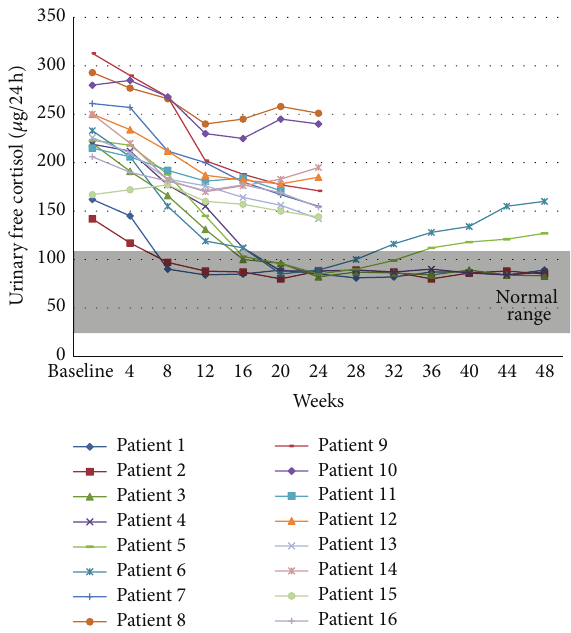
Figure 1: Patients UFC levels (baseline and during isotretinoin ther- apy). Ten patients ( 7 to 16 ) were withdrawn from the study at month 6 (week 24) due to poor response whereas the remaining 6 patients ( 1 to 6 ) were given an additional 6 months (24 weeks); 2 of them ( 5 and 6 ) subsequently developed relapse of hypercortisolism. Overall, 4 (25%) patients ( 1 to 4 ) achieved sustained UFC